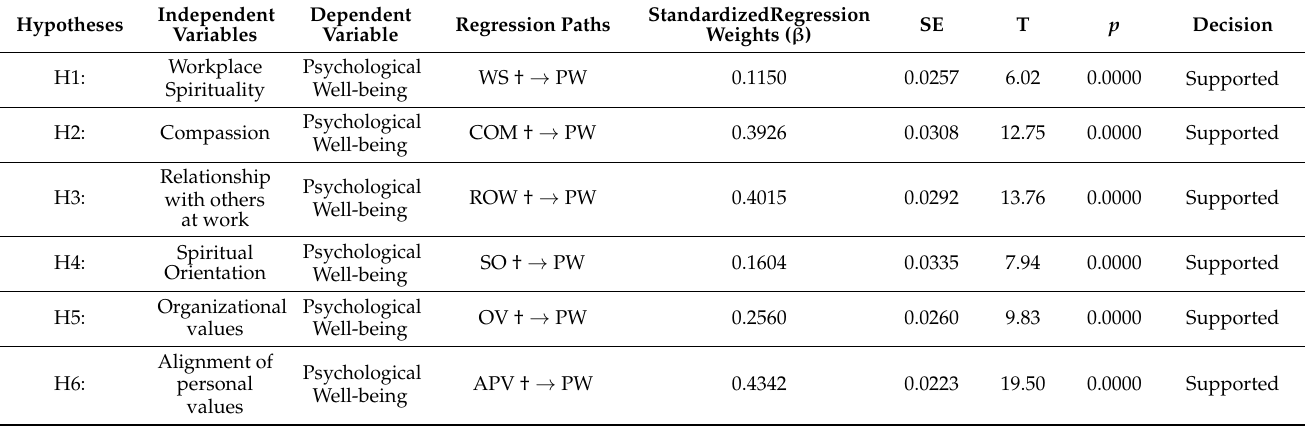
Table 7. Hypothesized direct